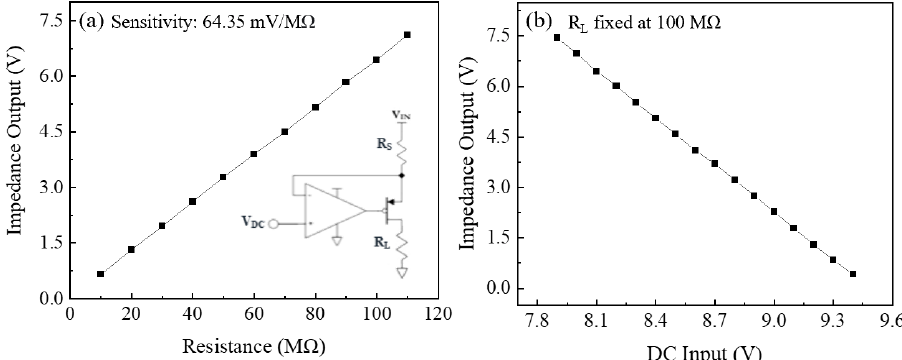
Figure 4. Voltage controlled current source (VCCS) testing result: ( a ) output voltage under varying R L when V DC is fixed, and ( b ) output voltage under varying V DC when R L is fixed.